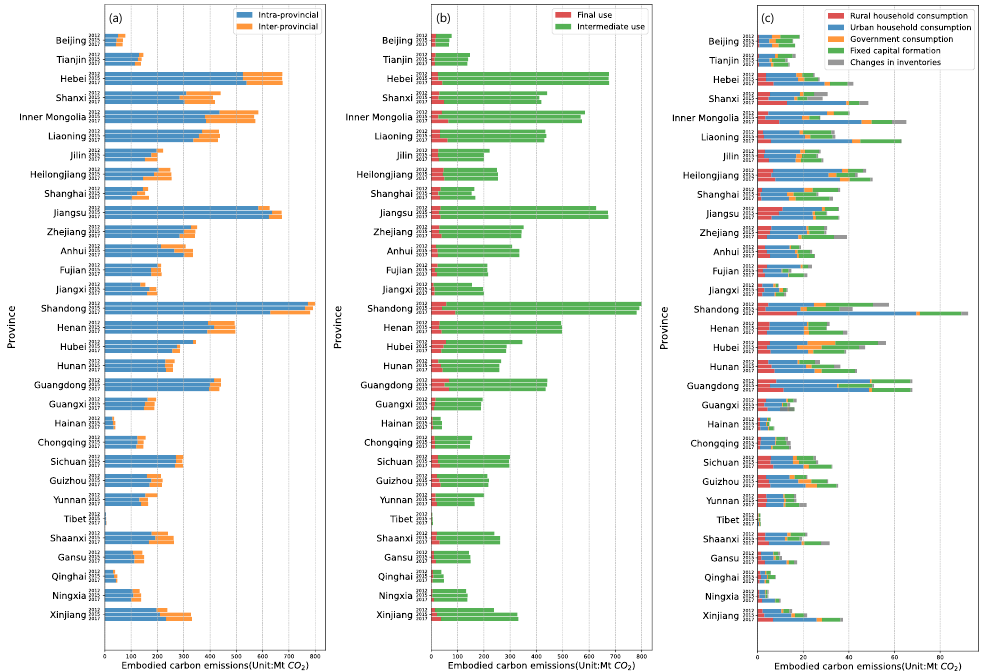
Figure 2. Embodied carbon emissions by province in China. ( a ) The scale of intra-provincial and inter-provincial embodied CO 2 emissions in each province. ( b ) The scale of embodied CO 2 emissions generated by intermediate use and final use in each province. ( c ) The scale of embodied CO 2 emissions from different categories of final use in each